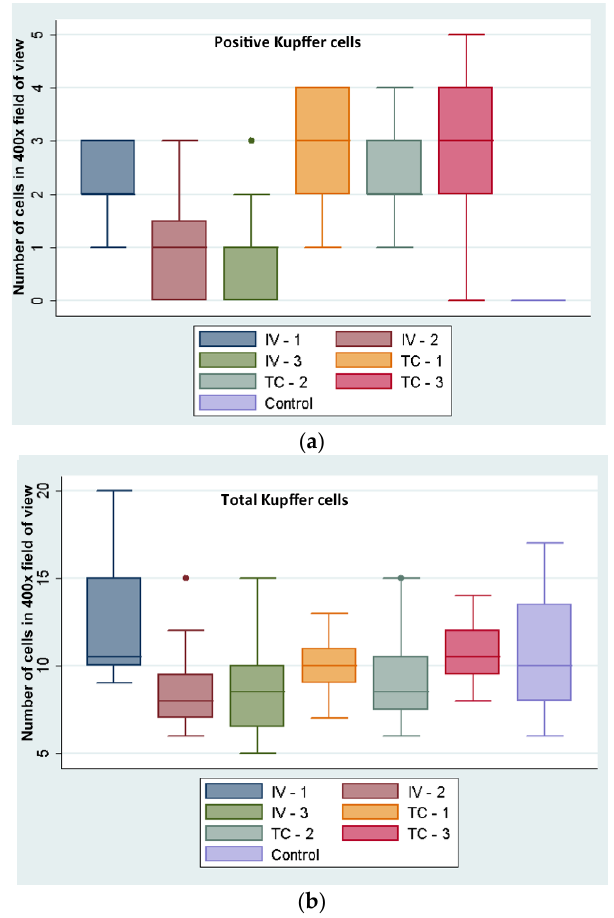
Figure 4. ( a ) NP positive Kupffer cells and ( b ) total number of Kupffer cells in livers of intravenous (IV) and intra-catheter (IC) injected and control rabbits. Y -axis indicates total number of Kupffer cells per field of view, averaged from 20 such areas, images acquired at 400 ˆ (for example, see one such area of view in Figure